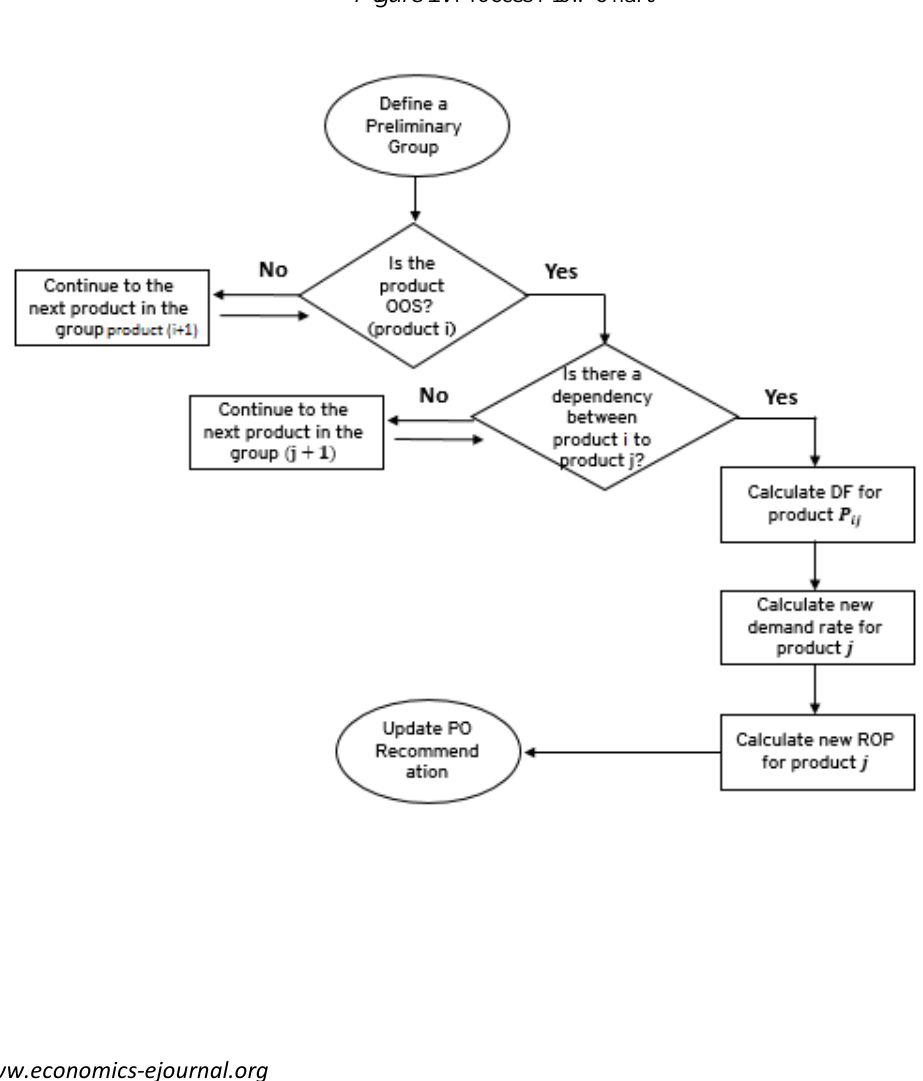
Figure 1: Process Flow